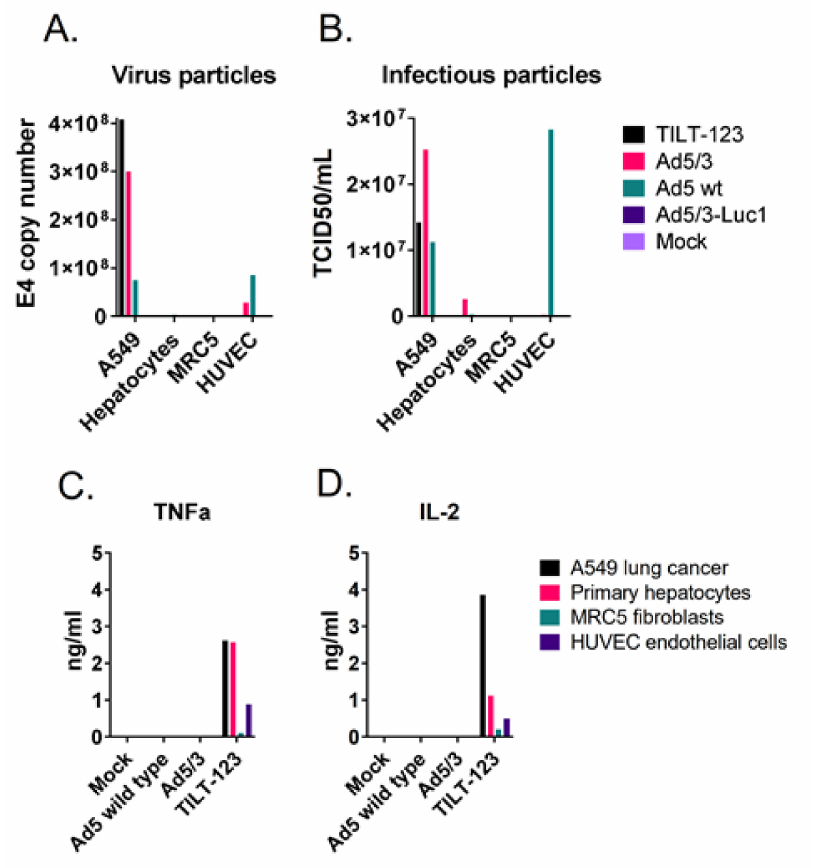
Figure 7. TILT-123 replicates selectively in cancer cells in vitro. A549 lung adenocarcinoma cells, human primary hepatocytes, MRC5 fibroblasts, and human vascular endothelial HUVEC cells were infected with TILT-123, Ad5/3 replicative control virus (similar selection device as TILT-123 but no cytokine payload), wild-type adenovirus type 5 (Ad5 wt), or replication-incompetent Ad5/3-Luc1 virus or left uninfected as a control (mock). ( A ) Virus genomes and ( B ) infectious virus particles were analyzed from the infected cells 72 h after infection. TILT-123 transgenes TNFa ( C ) and IL-2 ( D ) were analyzed from cell culture